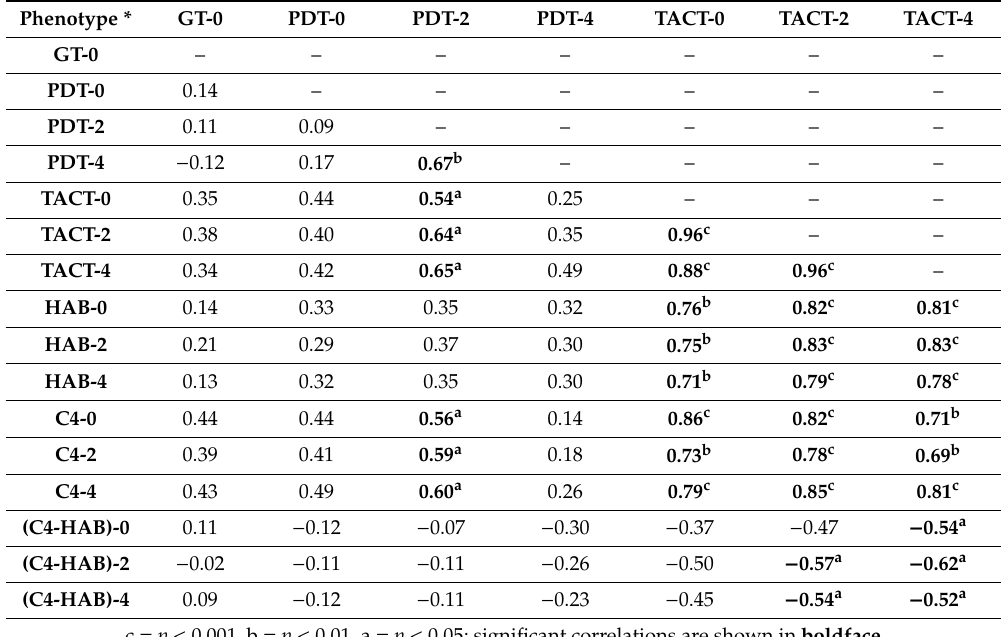
Genetic correlations (Pearson r ) between conditioned place aversion (CPA) and activity